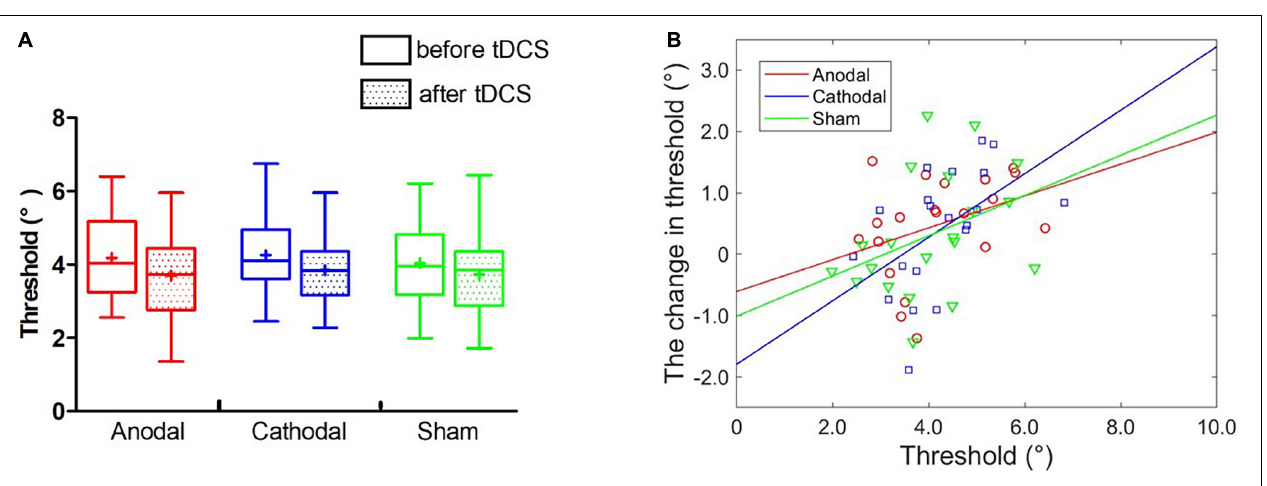
FIGURE 6 | Effect of tDCS over the right FFA on the threshold of face view discrimination. (A) The average thresholds are depicted before and immediately after tDCS. Error bars indicate standard errors (SE). (B) The baseline threshold as a function of the threshold changes for each